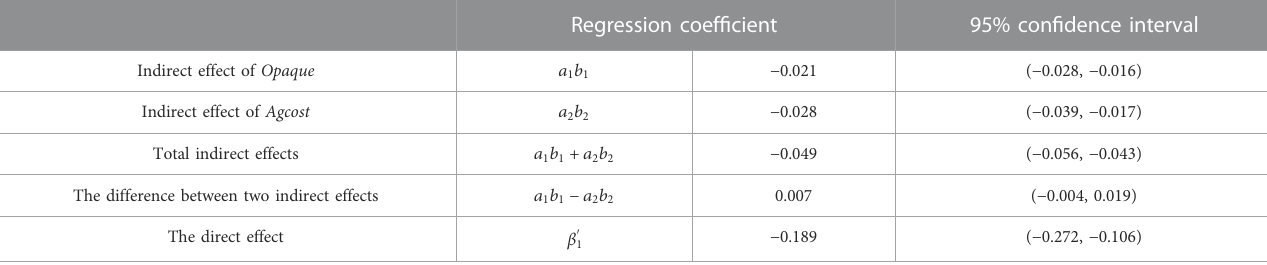
TABLE 6 Bootstrap test results for mediation